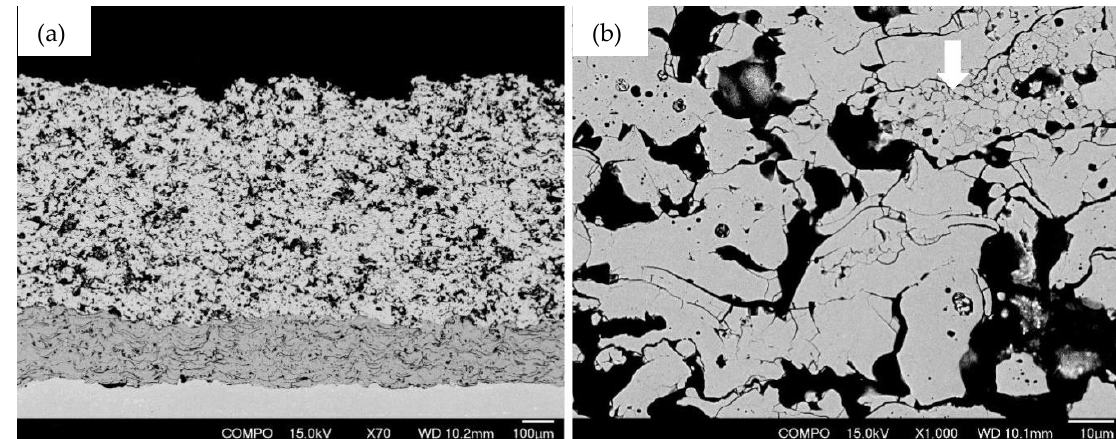
Figure 2. Microstructure cross-section of the reference coating produced with commercial powder and cascaded plasma system. Overall coating ( a ) and high-magnification images ( b ).